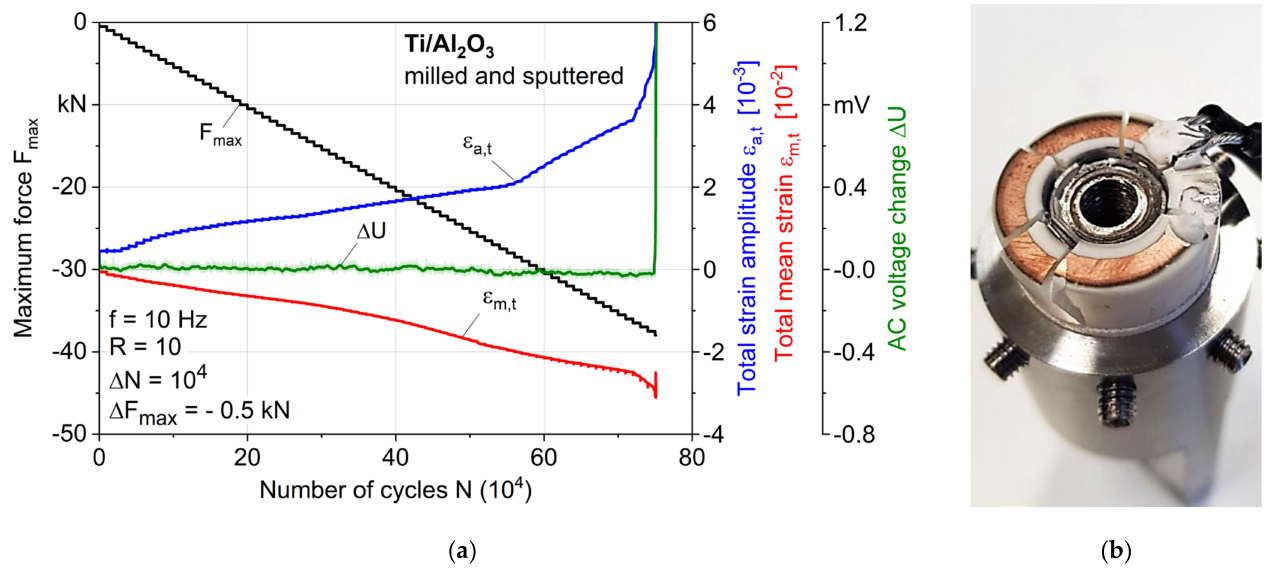
Figure 12. ( a ) Results of a multiple amplitude test (MAT), and ( b ) failed sample with milled and sputtered